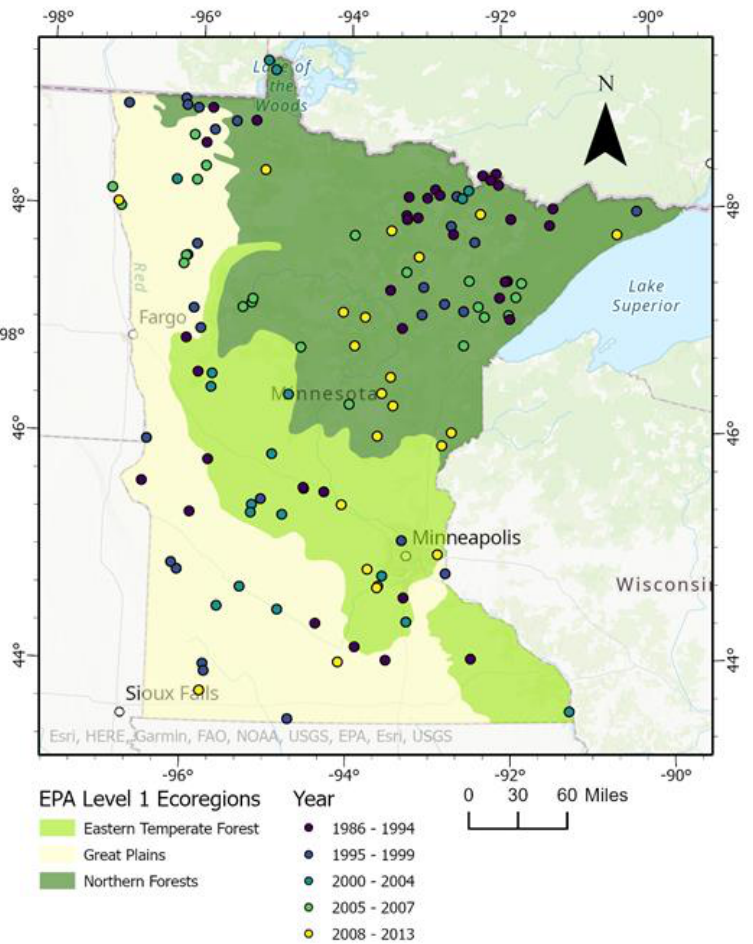
Figure 6. The temporal distribution of accuracy assessment errors. Error points show significant clustering by year (Moran’s I value of 0.2654, z-score of 6.14). This suggests that individual images in either the model development process or the independent reference set have a clear influence on errors in the